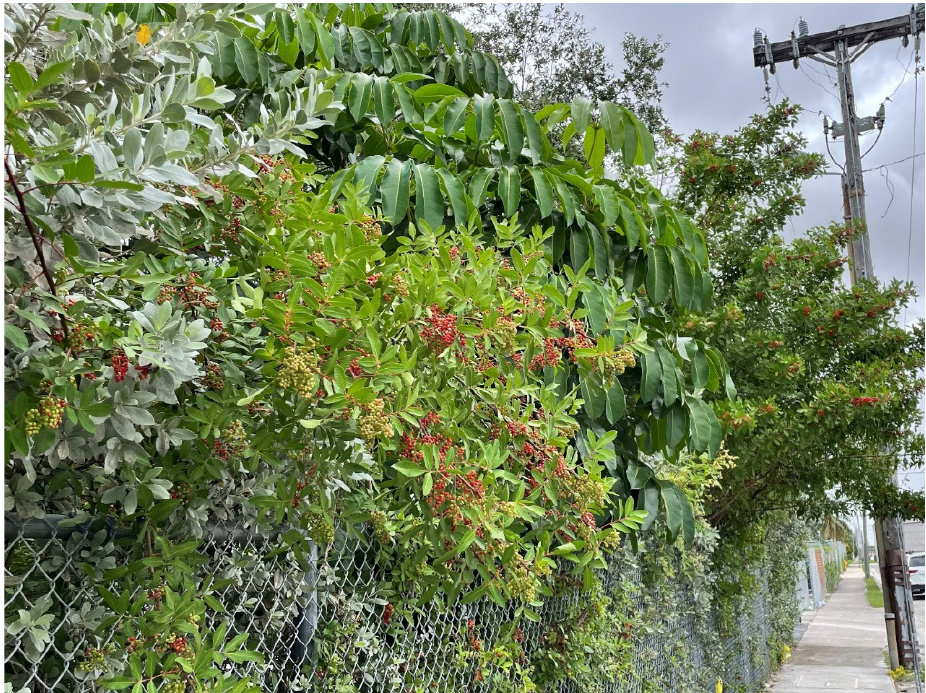
Figure 6. Planted hedge in one of the UF plots. Note the presence of the Brazilian pepper (red fruits, Schinus terebinthifo‐ lia ), planted next to the Florida native, buttonwood (far left, Cornocarpus erectus ), and the invasive Queensland umbrella tree (in between two stems of S. terebinthifolia ; Schefflera actinophylla